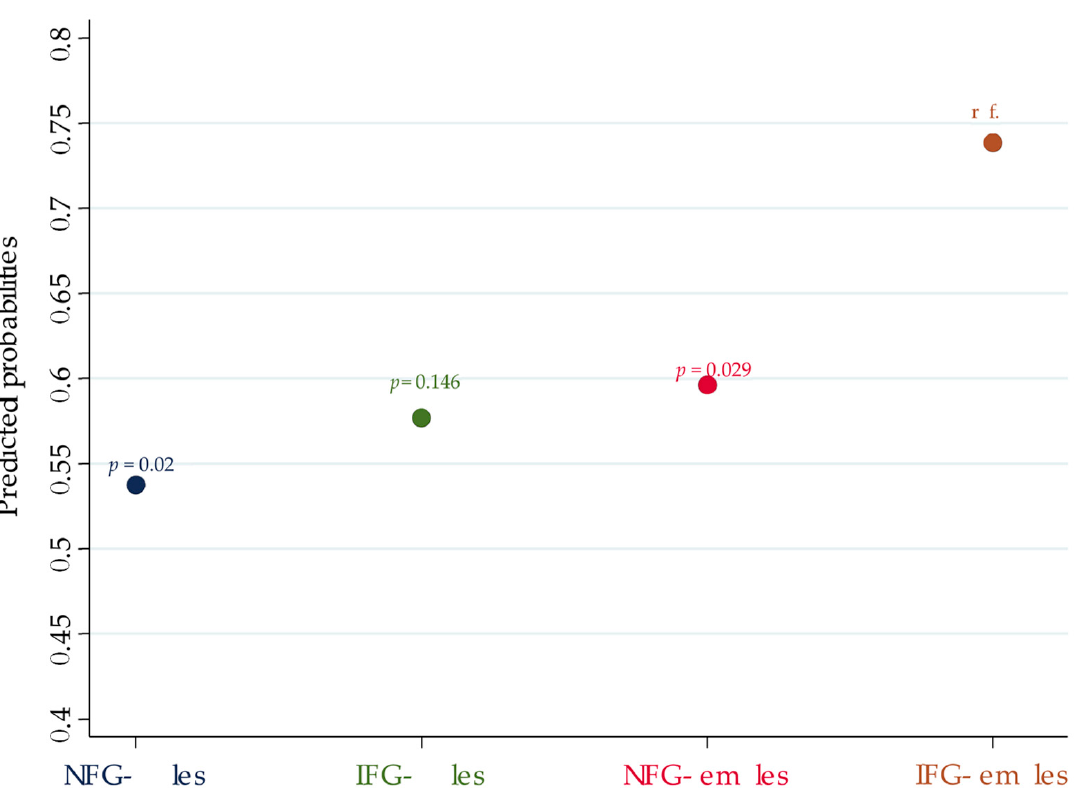
Figure 1. Pr(TN) of each interaction category according to sex and FPG. p-values refer to the analysis of the contrast between the Pr(TN) of the correspondent interaction category vs. the Pr(TN) of the reference group (IFG females).